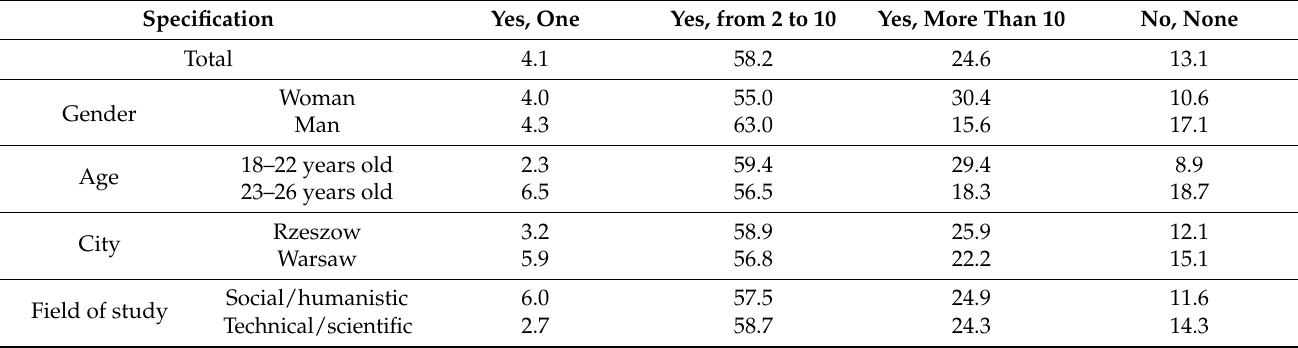
Table 3. Involvement of Generation Z respondents in the systematic tracking of influencers (in